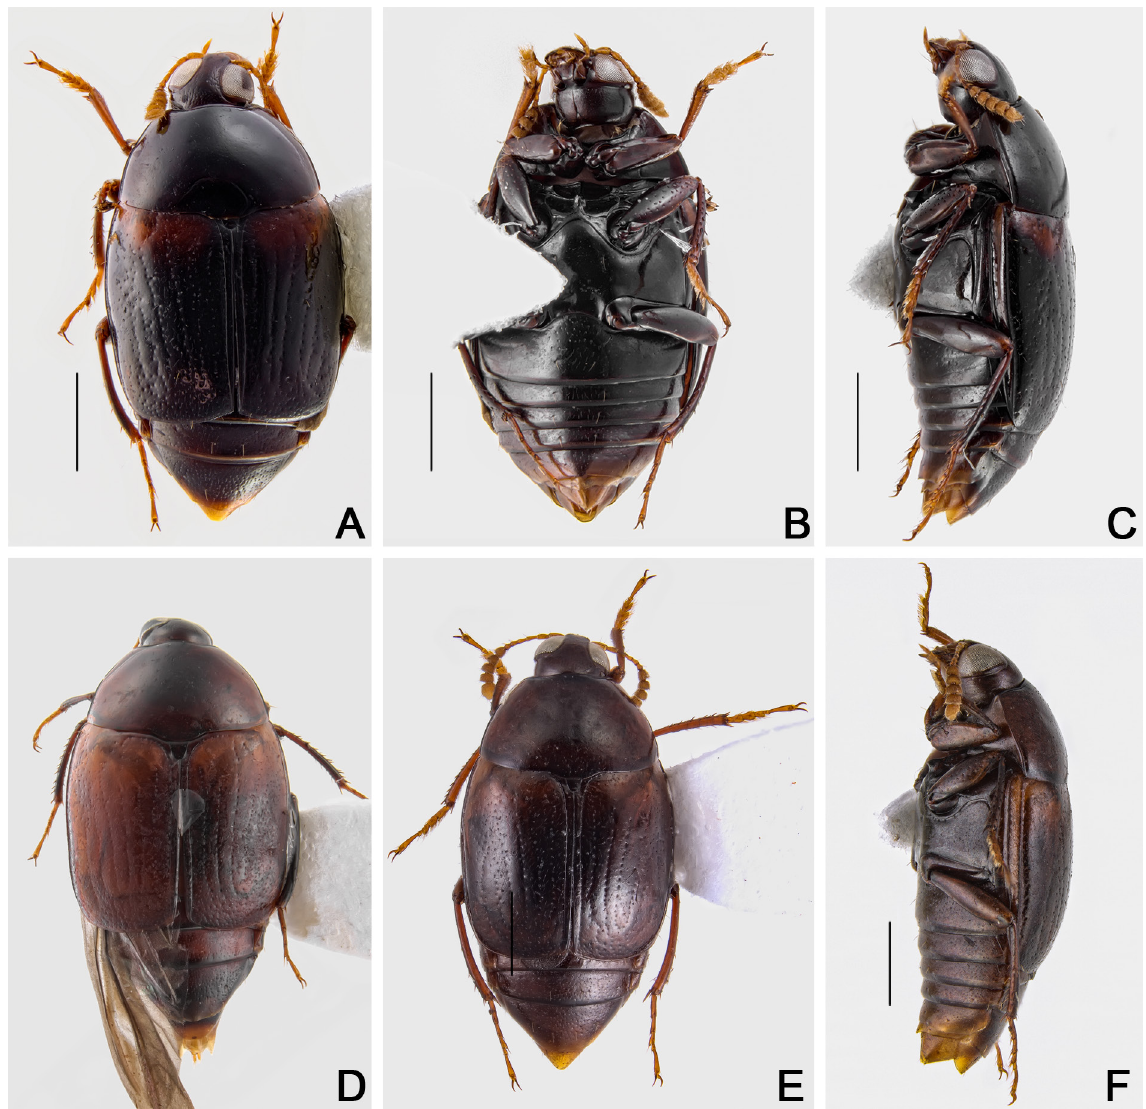
Fig. 38. Cyparium pici sp. nov. A–C . Holotype, ♂ (CEMT). A . Dorsal view. B . Ventral view. C . Lateral view. D . Paratype, ♀ (CEMT), dorsal view. E–F . Paratype, ♂ (CEMT). E . Dorsal view. F . Lateral view. Specimens collected at Cotriguaçu (MT, Brazil). Scale bars = 1.0